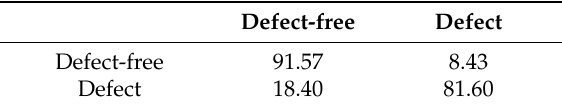
Table 2. Confusion matrix of the DCNN DND [%].